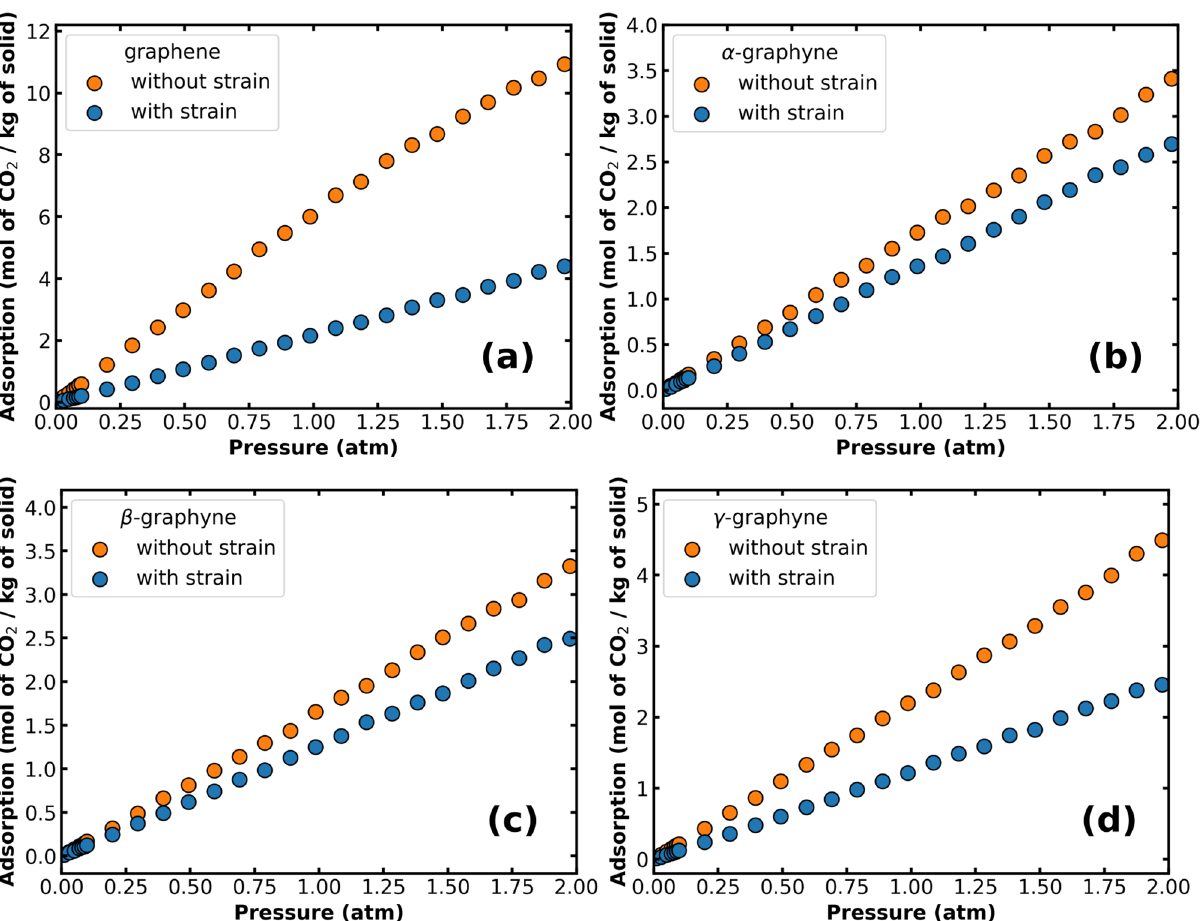
Figure 4. ( a – d ) Adsorption isotherms of CO 2 on graphene and the graphynes, comparing results with and without strain (T = 298